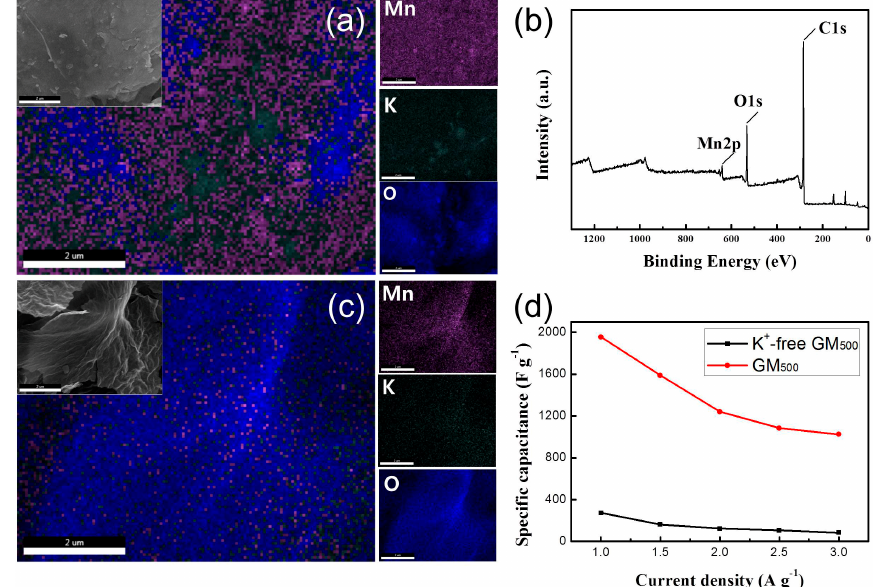
Figure 7. ( a ) Scanning electron microscopy (SEM) and EDS of GM 500 , ( b ) XPS survey scan of K + -free GM 500 , ( c ) SEM and EDS of K + -free GM 500 , ( d ) Specific capacitance versus current density of K + -free GM 500 .